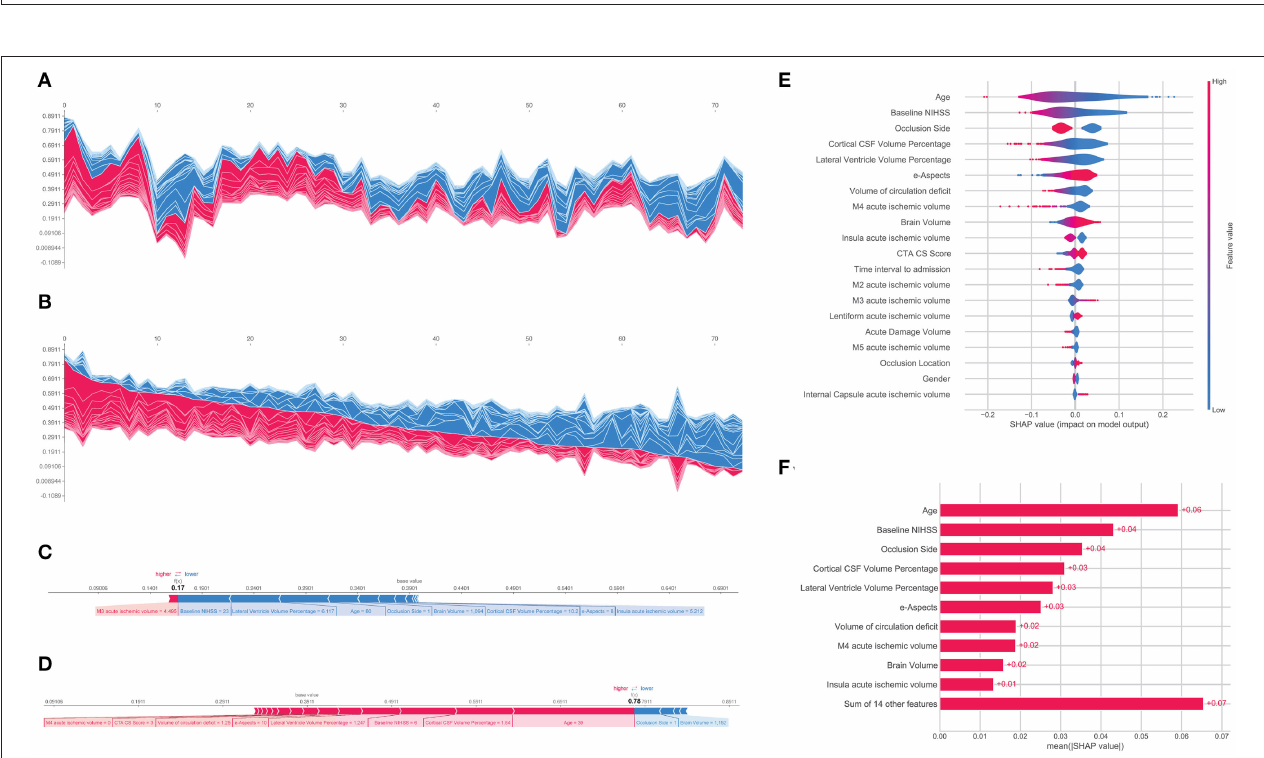
FIGURE 2 | Receiver operating characteristic curves (ROCs) with areas under curves for modified Rankin score at 90 days (mRS-90) prediction after grid-search optimization using baseline clinical features (A) , imaging features (B) , all features (C) , and selected features (D) , the orange-dashed line represents random guessing with an area under the receiver operating characteristic curve (AUC) of 0.5. The AUC (E) and confusion matrix (F) of the best performing model following Bayesian hyperparameter tuning using the selected features.